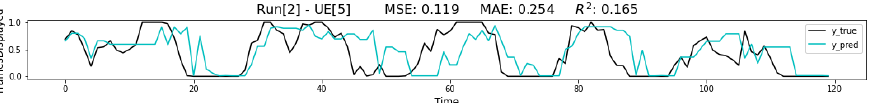
Figure 4. Real and predicted values of QoE for an example UE of the test set (Figure from [24]).